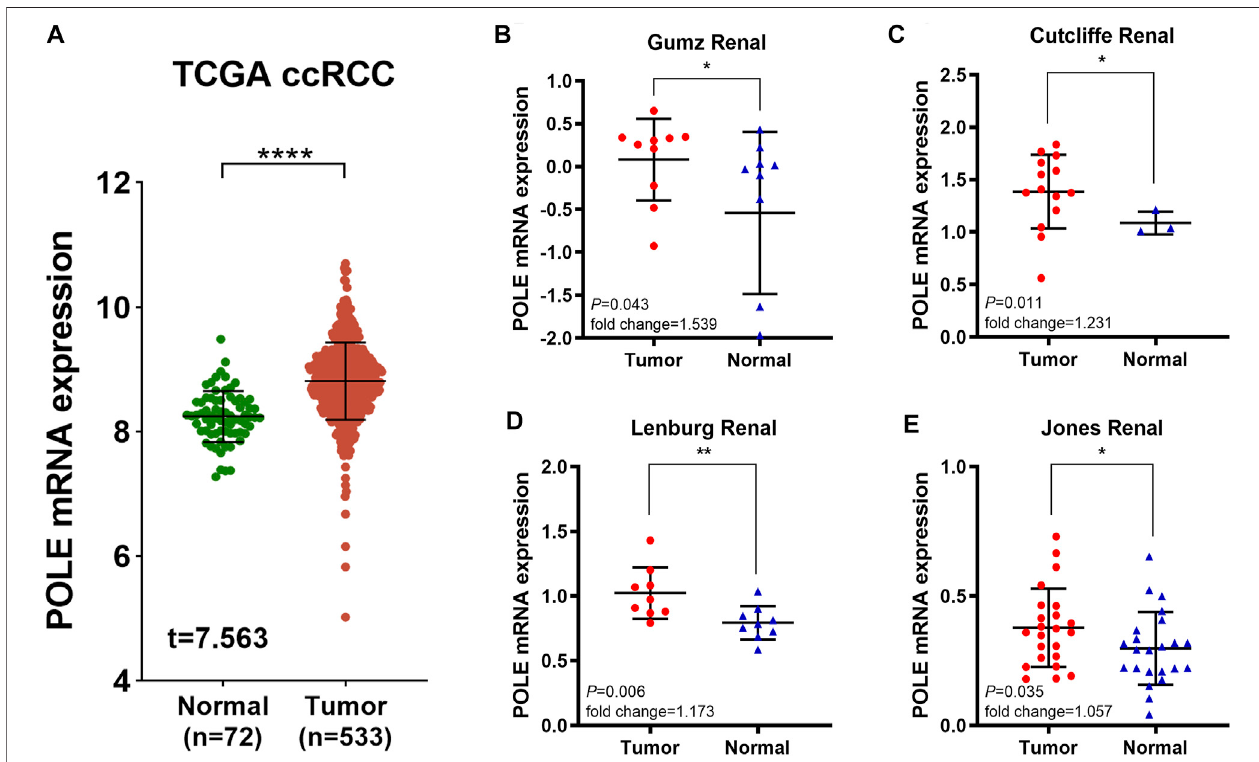
FIGURE1| Signi fi cantlyelevated polymerase epsilon(POLE)mRNAexpression inclear cellrenal cellcarcinoma (ccRCC)compared withnormaltissues. (A) POLE mRNA expression wassigni fi cantly higher in patients withccRCC compared withthose ofnormal tissues(The Cancer Genome Atlas [TCGA] database). (B – E) Fourtest cohorts provided differential RNA-seq data in ccRCC and normal samples. The results suggested signi fi cantly elevated POLE expression levels in ccRCC tissues compared with normal tissues. The test cohorts were as follows: Gumz Renal ( n (cid:1) 10; p (cid:1) 0.043), Cutcliffe Renal ( n (cid:1) 14; p (cid:1) 0.011), Lenburg Renal ( n (cid:1) 9; p (cid:1) 0.006), and Jones Renal ( n (cid:1) 23; p (cid:1)